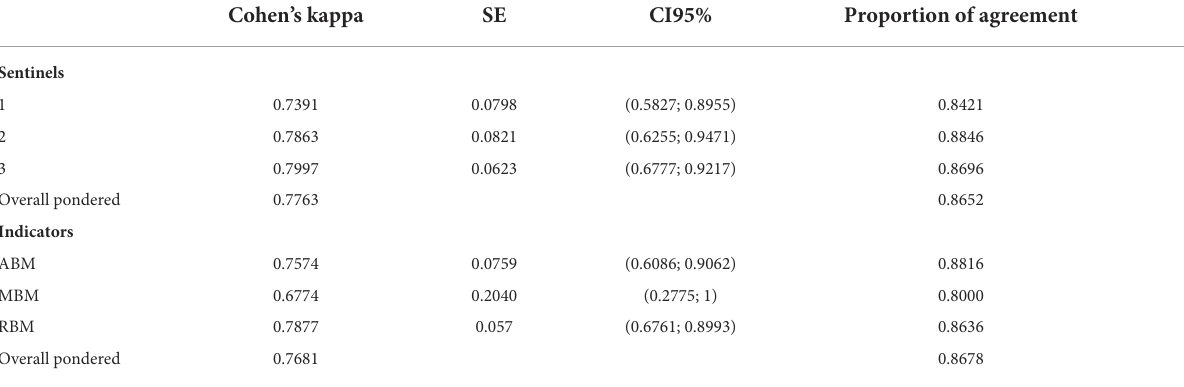
TABLE 3 Test-retest reliability calculated for the on-field test of Ackonc-AWA